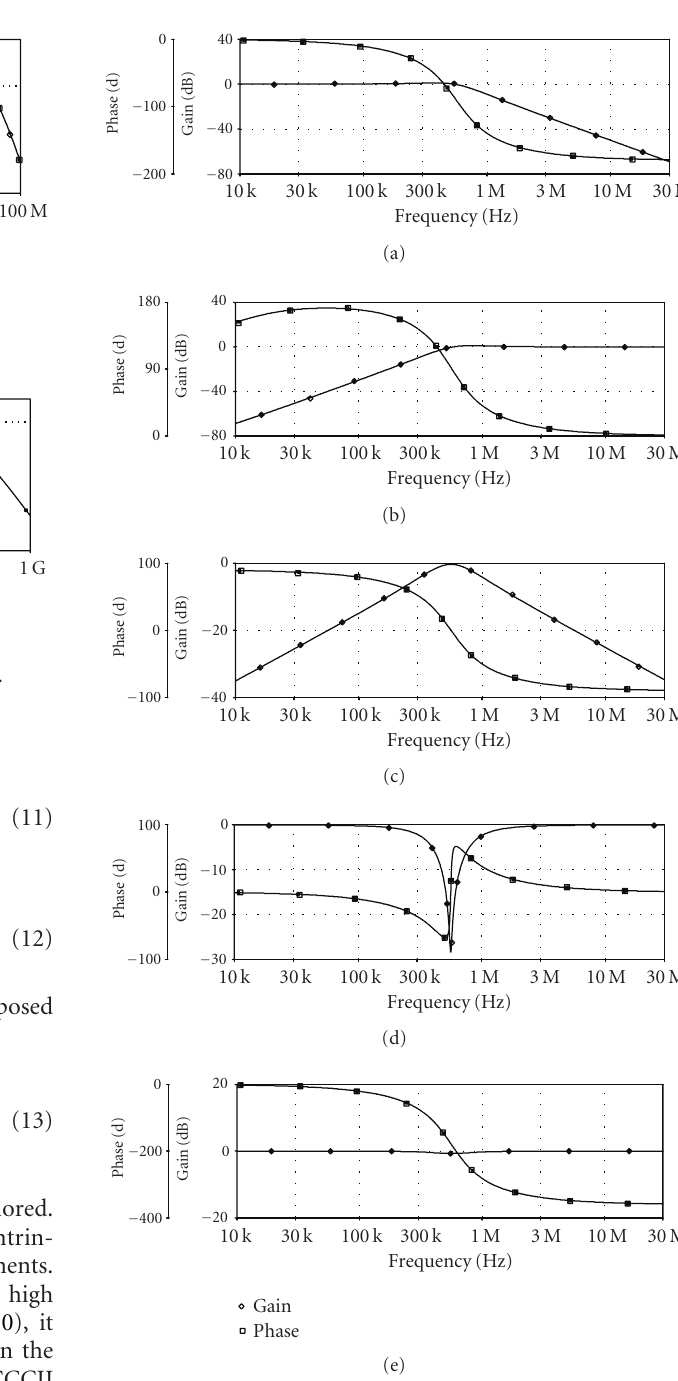
Figure 5: Gain and phase responses of the biquad filter in voltage- mode for (a) LP, (b) HP, (c) BP, (d) BR, (e)